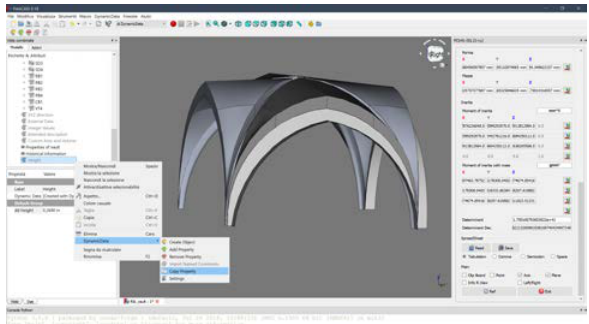
Figure 13. Detail of dynamic data tools inside